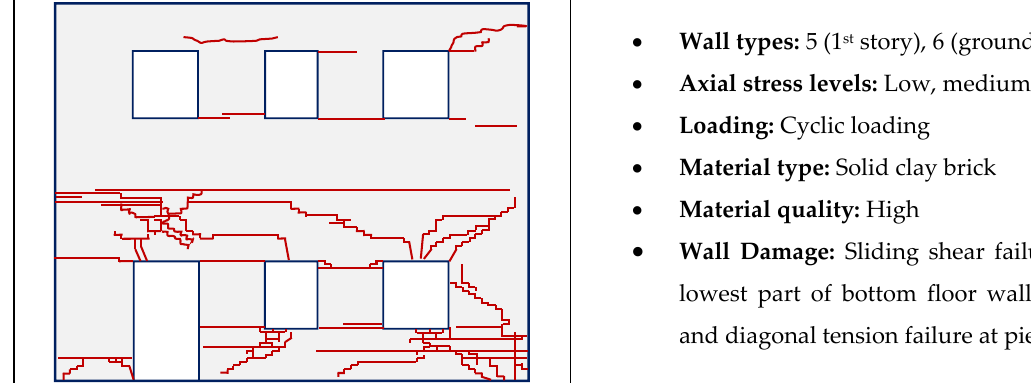
Figure 6. Illustrations for the collected damage data from experimental campaigns by Kalali and Kabir [34] and Moon et al. [31].